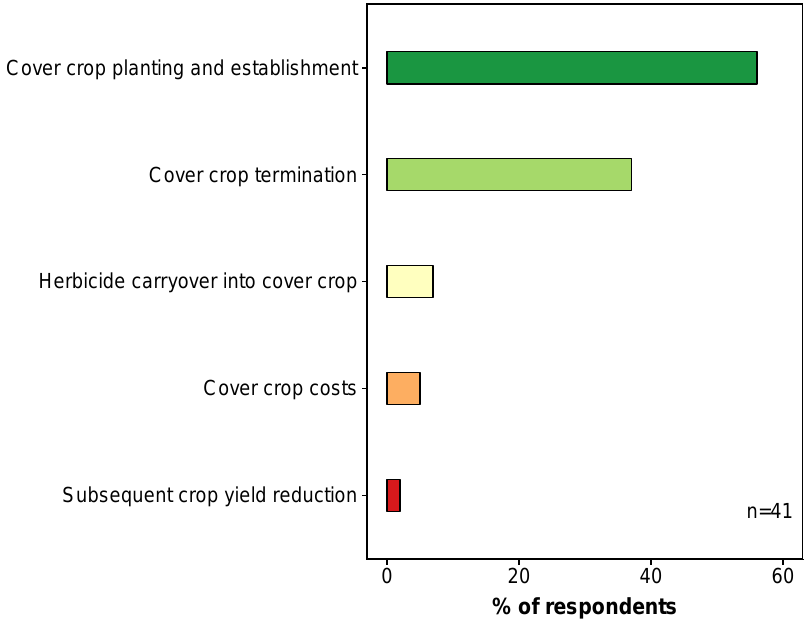
Figure 7. Challenges for adopting cover crops according to survey respondents of